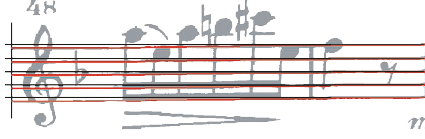
Figure 6: Accurate detection of warped sta ff